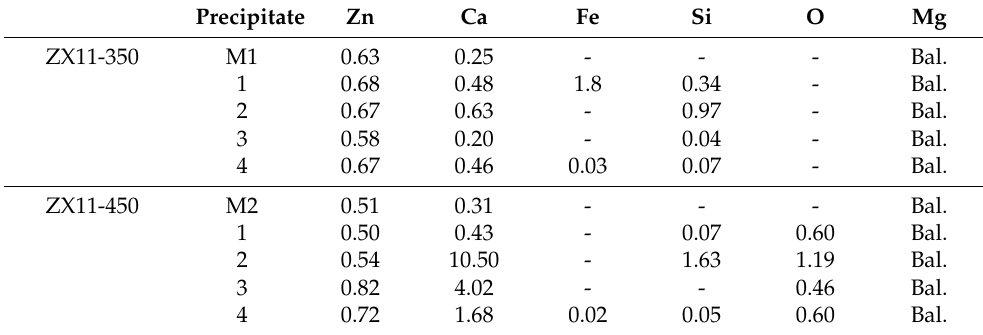
Table 1. Chemical composition of selected precipitates in Figure 1c,d was determined using EDS. Precipitate